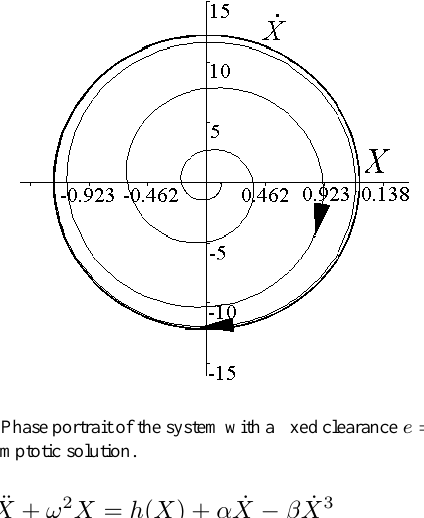
Fig. 3. Phase portrait of the system with a fixed clearance e = 0 . 001 via asymptotic